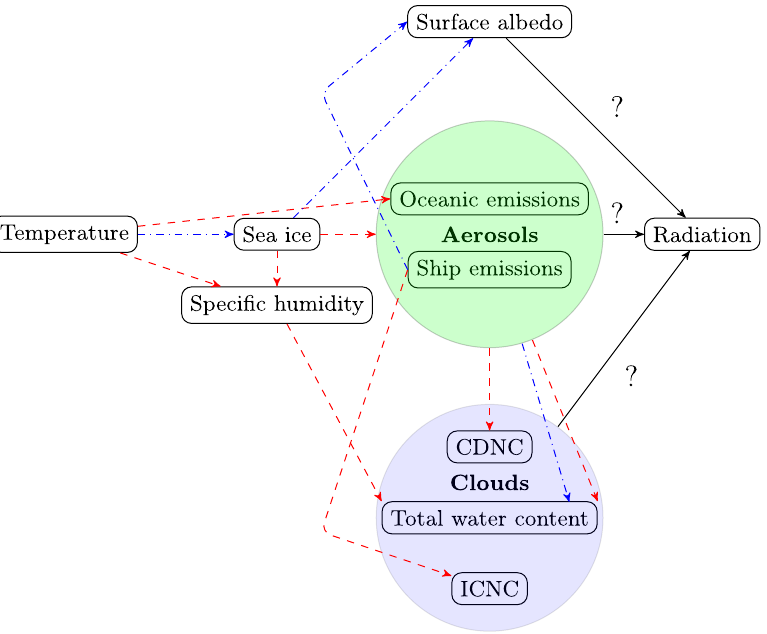
Figure 1. Simplified sketch showing how different variables (may) vary as a result of enhanced Arctic temperatures. Red dashed arrows denote expected increases, blue dashed–dotted arrows expected decreases. Black solid arrows show which components impact radiation. CDNC and ICNC stand for cloud droplet and ice crystal number concentration, respectively. Note that an increase in aerosol concentrations can either increase or decrease precipitation and thus the total water content, as mentioned in Sect.